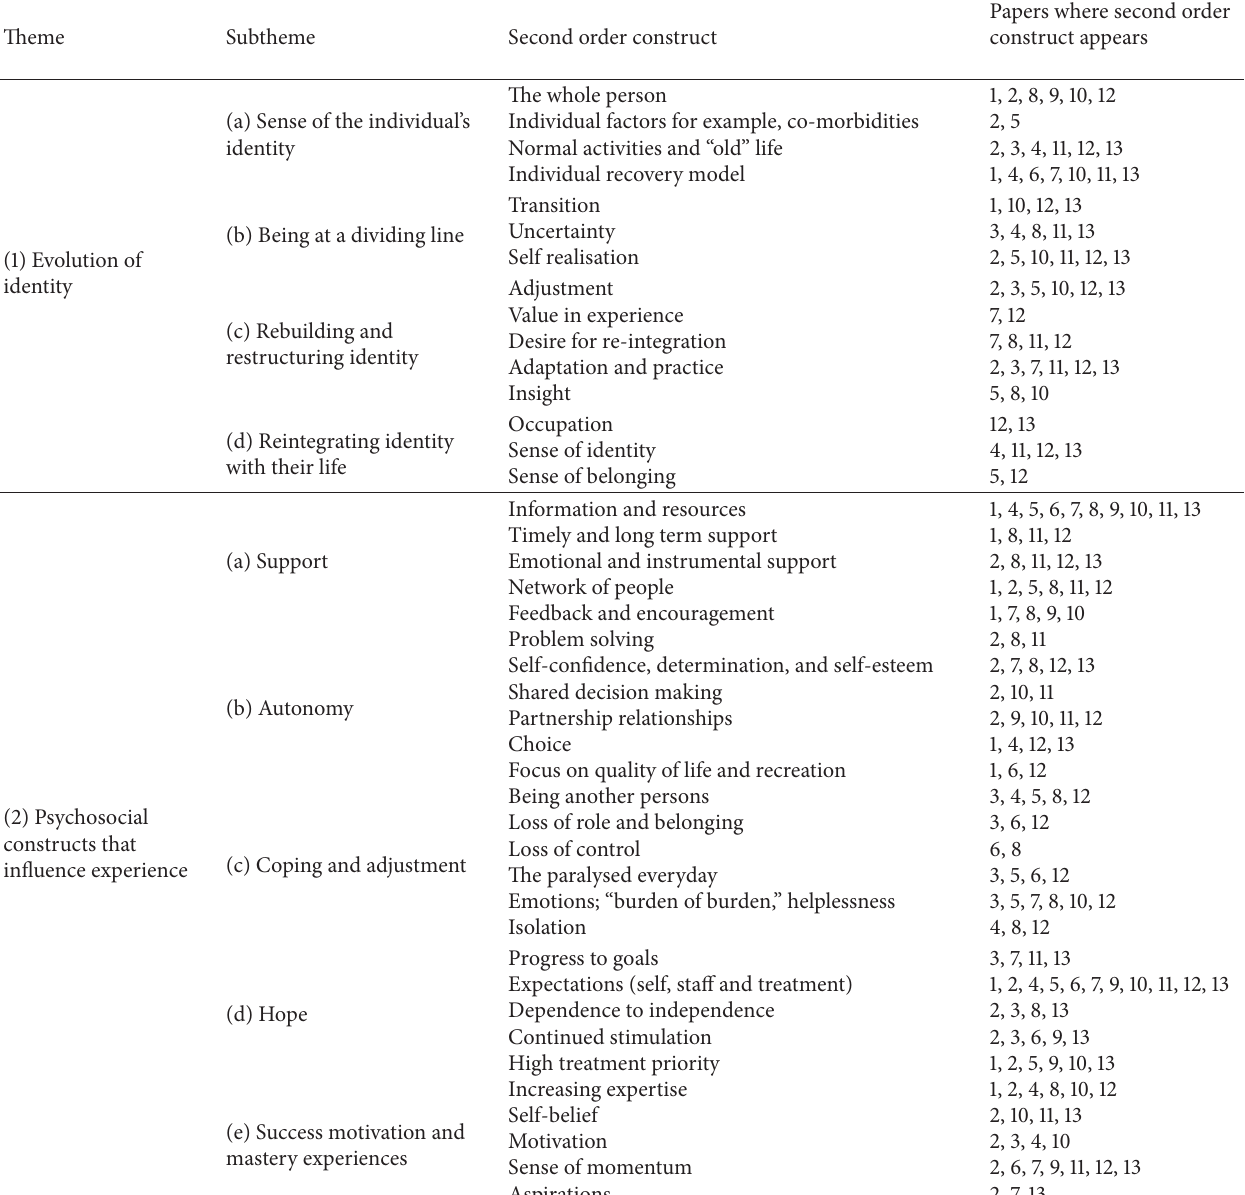
Table 4: Findings of the synthesised